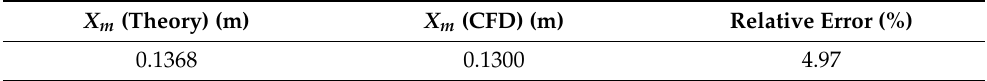
Figure 8. CH 4 m.f. contour plot on the SB faces.